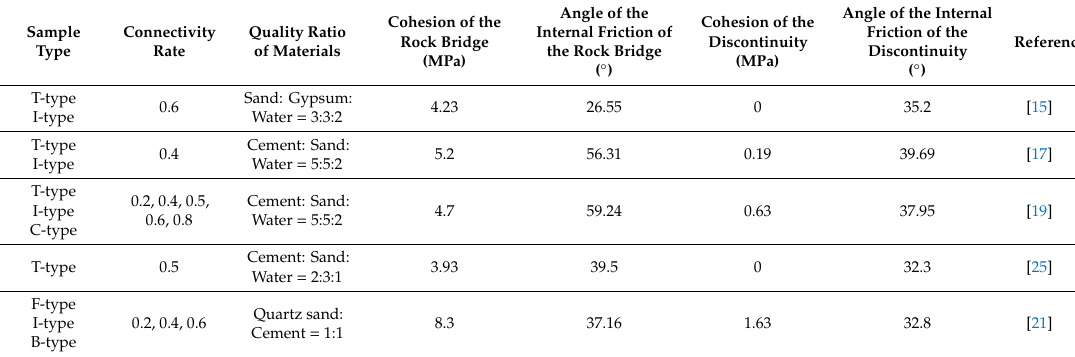
Figure 1. Schematic diagram of artificial rock mass samples with various discontinuity positions and connectivity rates. Table 1. Strength parameters of artificial rock mass samples with various discontinuity positions and connectivity